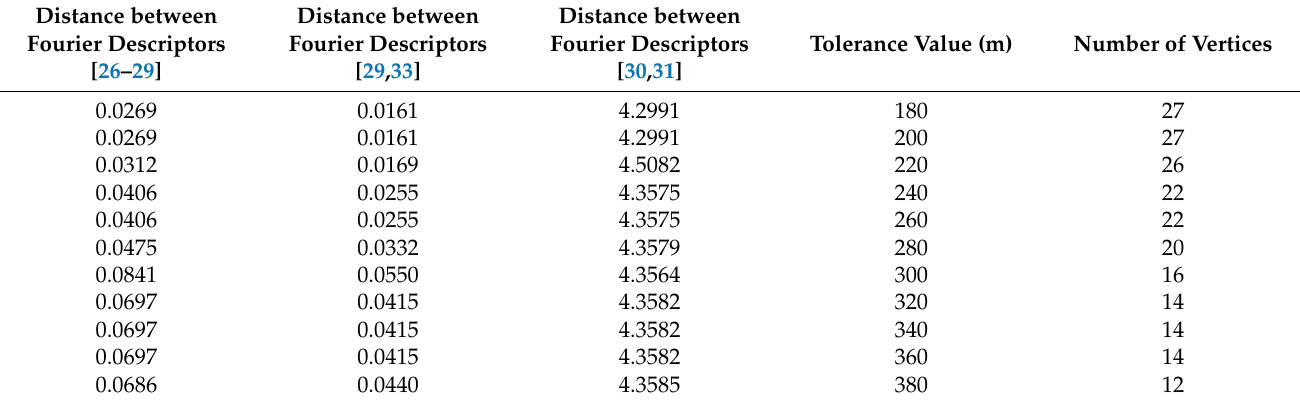
Table 8. Distances between Fourier descriptors for polygon